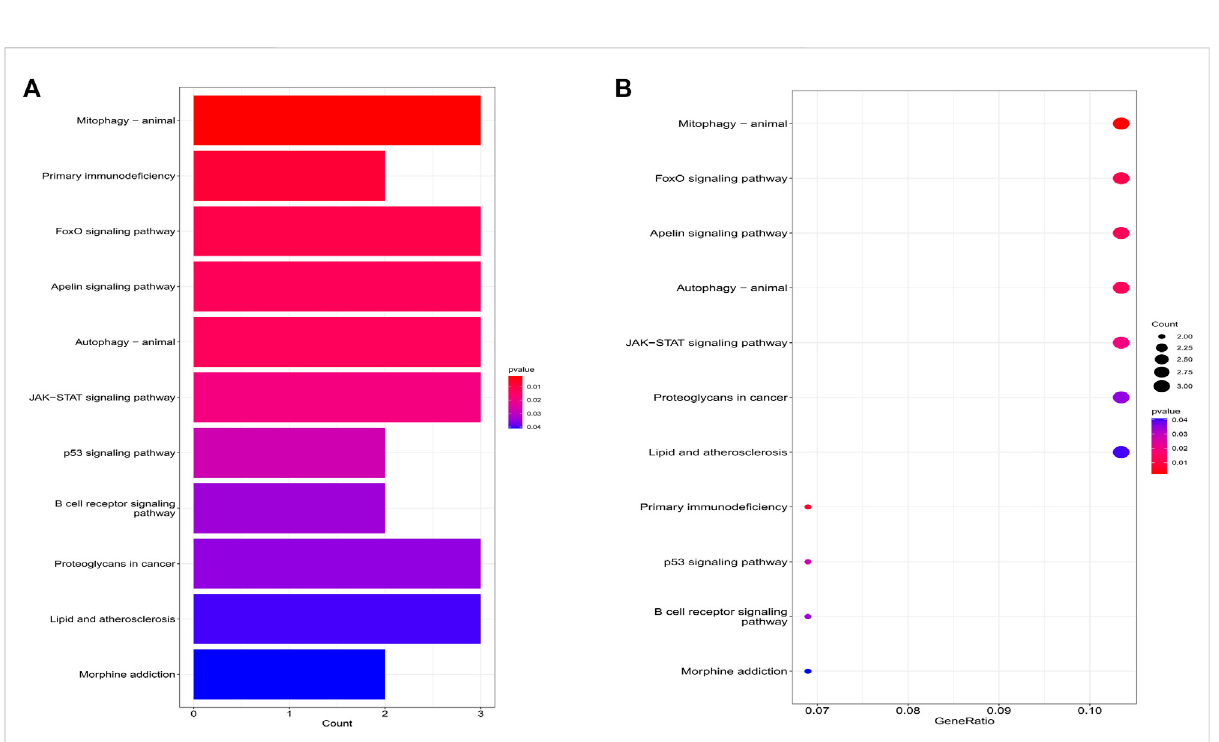
FIGURE 3 Results of KEGG analysis. (A) Bubble diagram; (B) bar